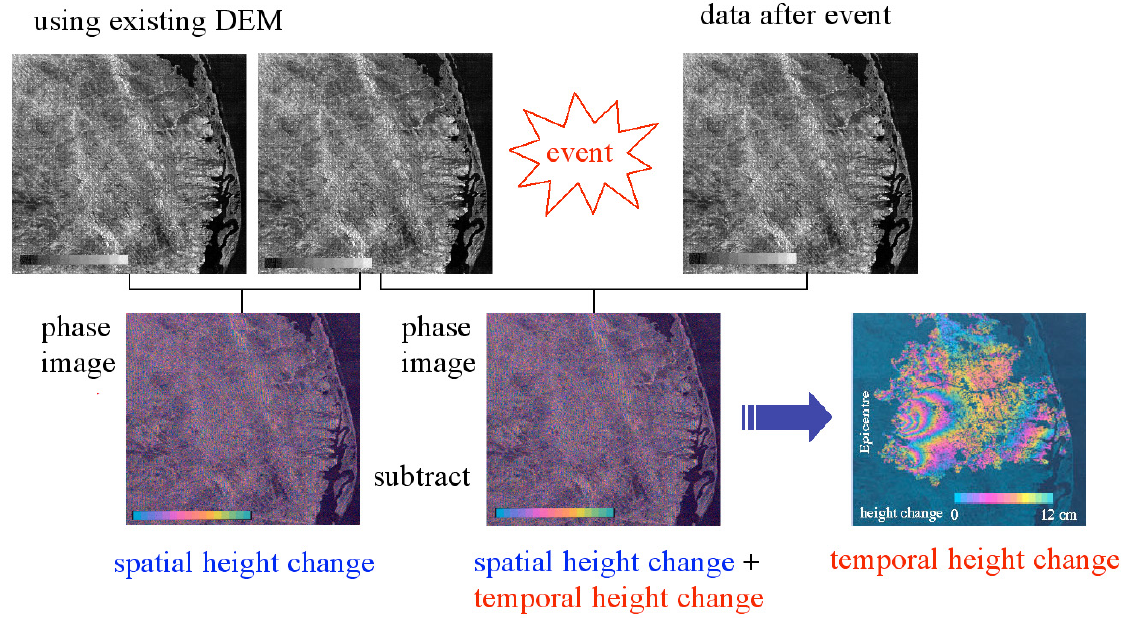
Figure 13. Flow for the measurement of surface elevation change by DInSAR. The raw JERS-1 SAR data were provided by JAXA, and processed by the author’s research